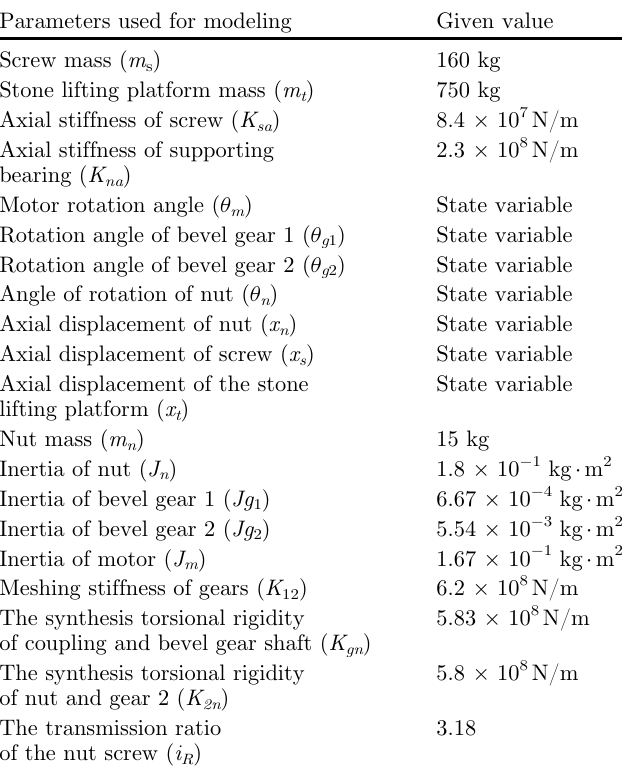
Table 1. Parameters used in modeling of